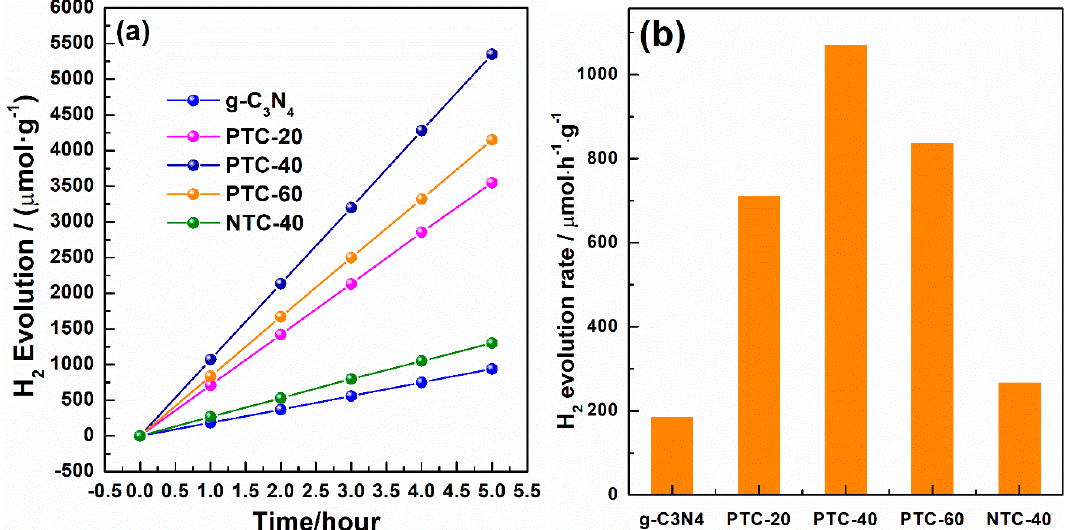
Figure 10. ( a ) Time course of hydrogen evolution and ( b ) hydrogen generation rate of the samples.